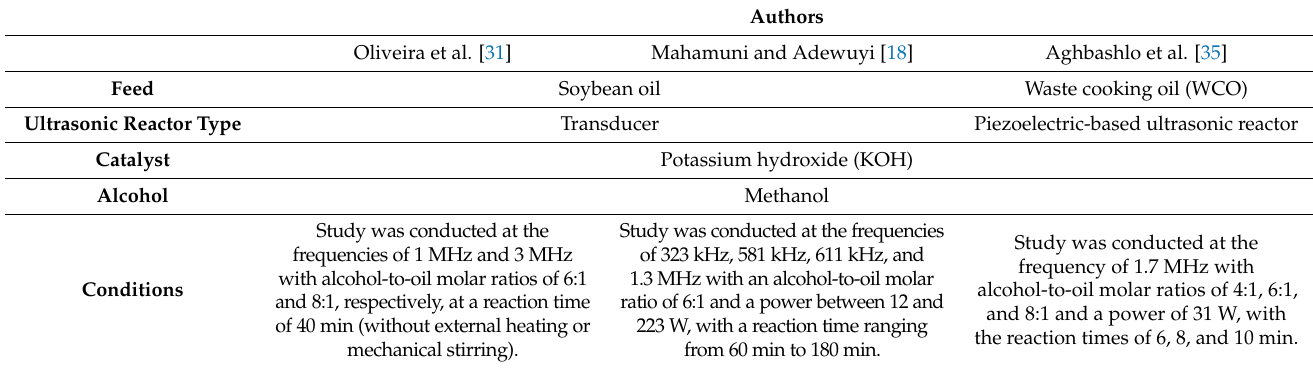
Table 2. Reaction conditions for high-frequency ultrasound-assisted transesterification.